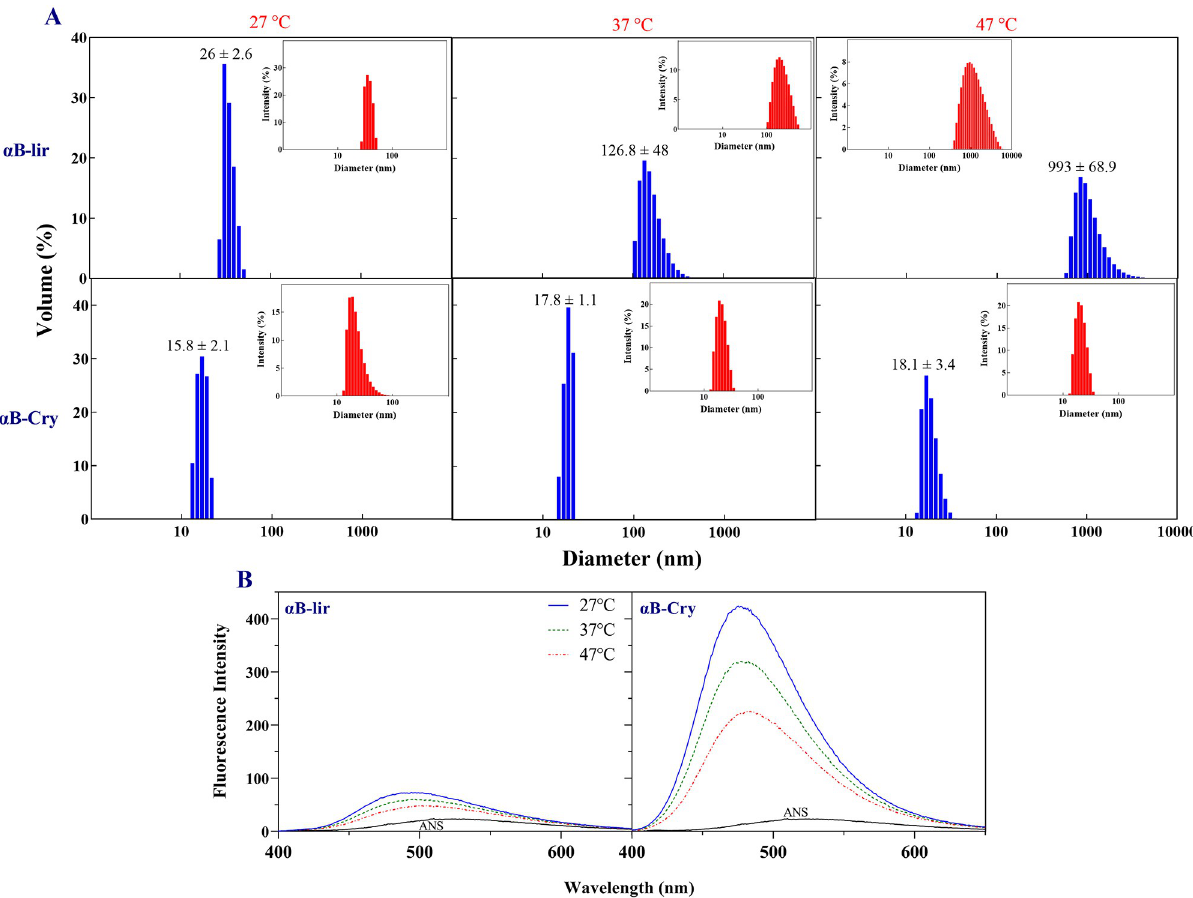
Fig 6. Oligomerization status and surface hydrophobicity of α B-lir hybrid protein. A ) The hydrodynamic diameters of α B-lir hybrid protein and human α B-Cry (1 mg/mL in phosphate buffer, pH 7.4) were measured at different temperatures by a DLS instrument. B ) For the ANS fluorescence assessments, the α B-lir and α B-Cry were prepared in 50 mM sodium phosphate buffer, pH 7.4 and the protein concentrations were fixed at 0.15 mg/ mL. Then, their surface hydrophobicity analyses were performed at various temperatures in the presence of a fixed ANS concentration (100 μ M). The excitation of the protein/ANS complex was done at 365 nm, and the emission spectra were collected between 400–600 nm. Also, the excitation and emission slits were fixed at 5 and 10 nm, respectively [44].